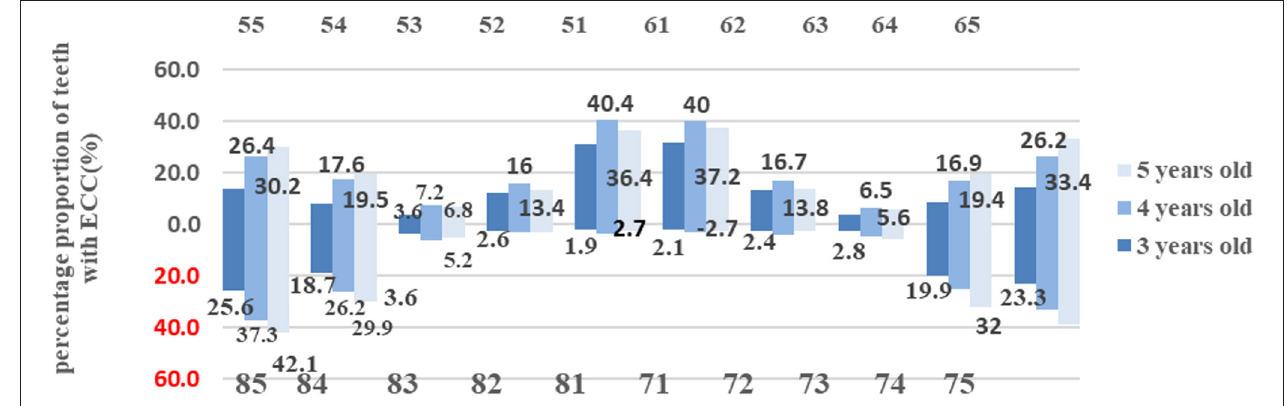
FIGURE 2 | The distribution of primary caries in each tooth position in children aged 3–5 years in Guizhou